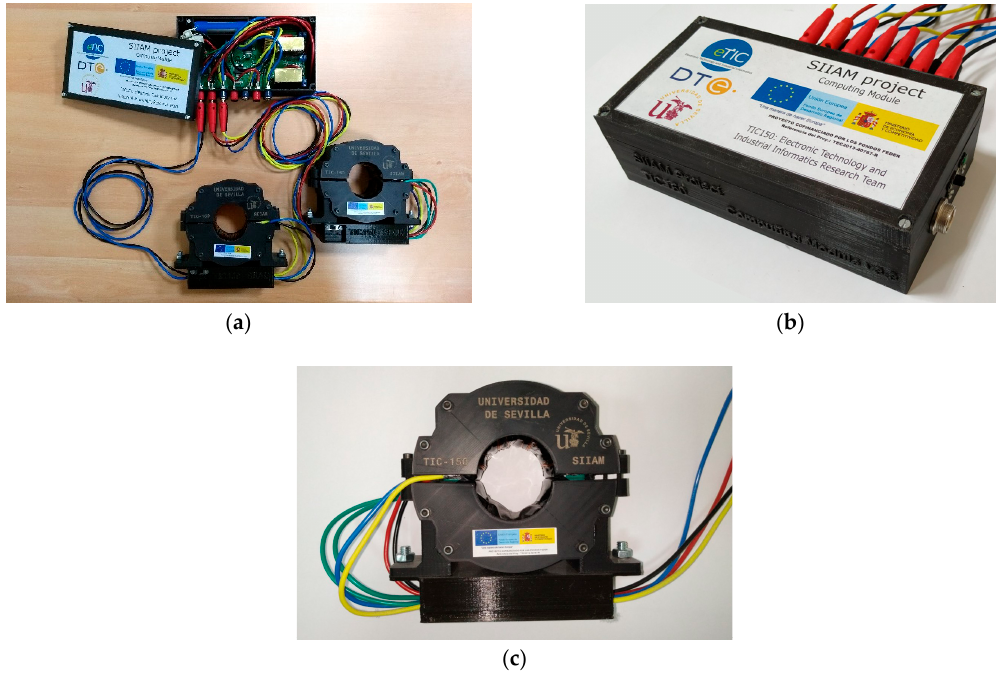
Figure 12. Node sensor prototype: ( a ) Node (opened); ( b ) Node (closed); and (c) Coupler.